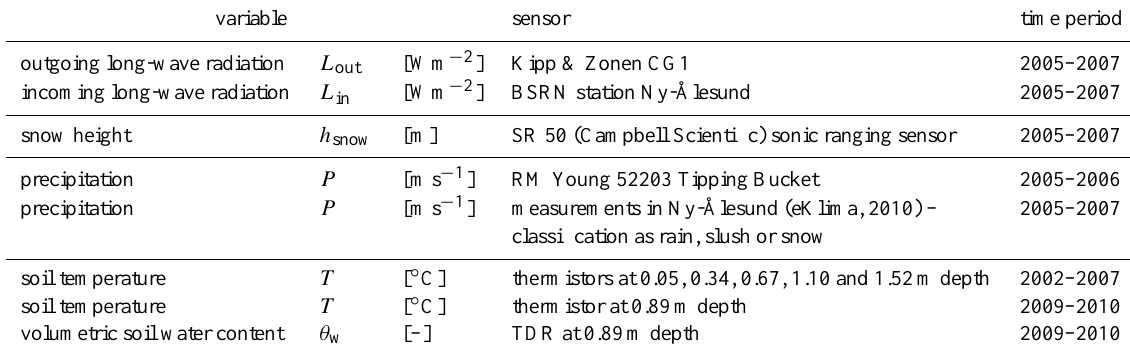
Table 1. Data sets employed in this study. If not mentioned otherwise, the installations are located at the Bayelva station.